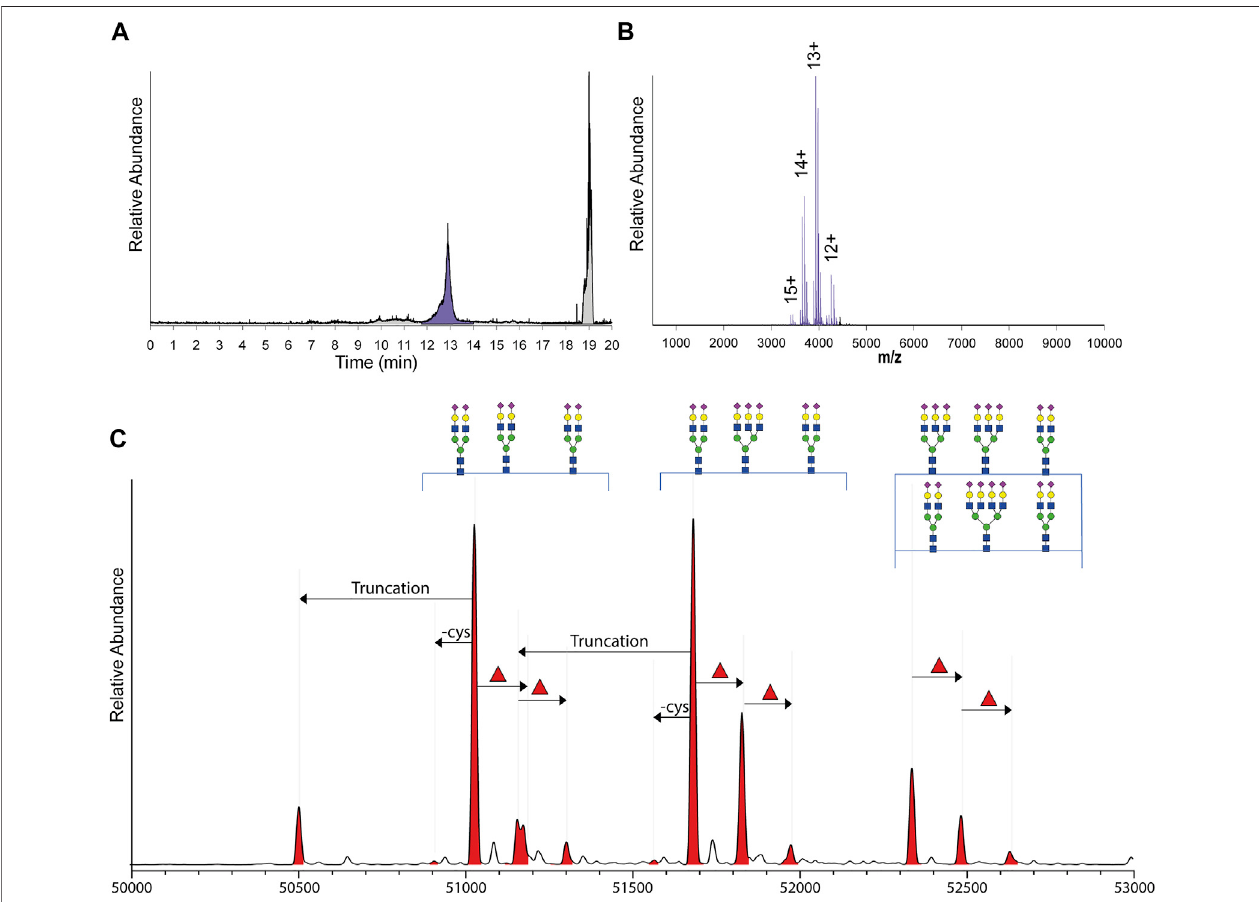
FIGURE 2 | From SEC fractionation of immune-puri fi ed A1AT to annotated qualitative and quantitative proteoform pro fi les. (A) Typical total ion current (TIC) chromatogram obtained by SEC-nMS following injection of immune-puri fi ed serum or milk A1AT, with the fraction containing A1AT highlighted in purple and all other fractions in grey. (B) Typical, non-processed native ESI-spectrum of A1AT with observed charge states annotated. (C) The zero-charge mass deconvoluted spectrum revealing mass peaks between 50 and 53 kDa all annotated as different A1AT proteoforms. The main peaks are annotated by their glycan composition and indicated with arrows are the additional annotated PTMs: the N-terminal truncation (truncation), decysteinylation of C256 (-cys), and additional fucoses (red triangle) which can either be located on the antennae or on the glycan